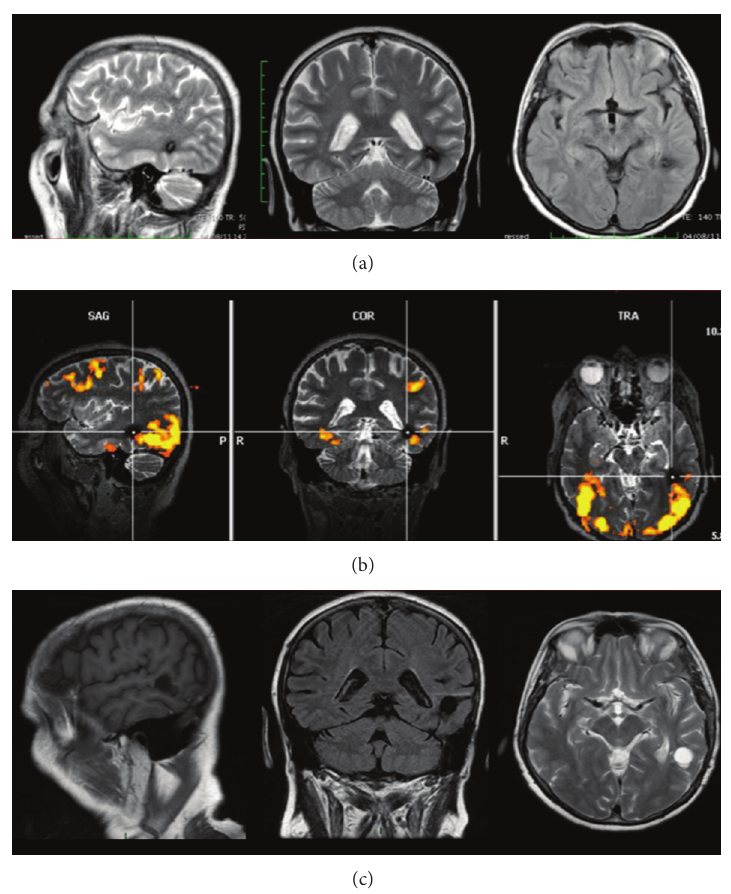
Figure 2: (a) Preoperative MRI sequences (sagittal T2, coronal T2, and axial Flair) showing a 1cm mixed-intensity lesion with a hypointense rim into the subcortical region of the middle temporalgyrus (MTG) directly in contact to the stems and/or terminations of the subcortical language pathways of this region (i.e., inferior fronto-occipital fasciculus, arcuate fasciculus, and indirect posterior component of superior longitudinal fascicle). (b) The preoperative 4T f-MRI (MR Scanner MedSpec, Bruker) showing the main activation during language task of the posterior temporal lobe on sagittal, coronal, and axial planes. The f-MRI demonstrated significant activations at the level of the posterior thirds of inferior temporal gyrus (ITG) and MTG in the BA 37 and in the occipital laterobasal cortex in the BA 19. No activations were detected at the level of the classical Wernicke’s area at the level of the posterior thirds of the MTG and superior temporal gyrus (STG) and perisuperior temporal sulcus (STS) in the BA 22. (c) The postoperative MR sequences (sagittal T1, coronal Flair, and axial T2) demonstrated the complete resection of the cavernous angiomas (CA) and of the perilesional hemosiderin gliotic rim. CA: cavernous angiomas; ITG: inferior temporal gyrus; MTG: middle temporal gyrus; STG: superior temporal gyrus; STS: superior temporal